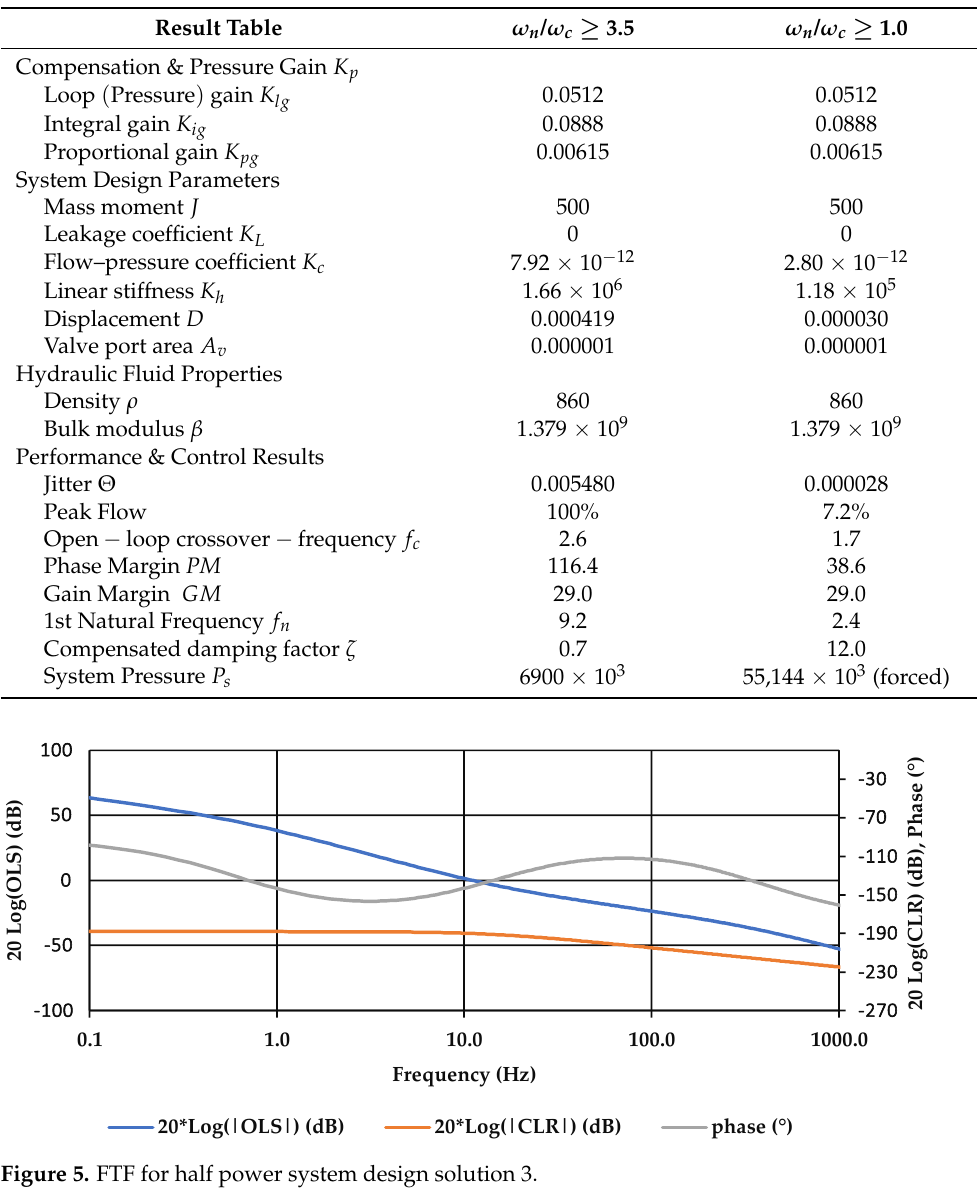
Figure 7. Frequency response for unbound system design solution 2. 4. Discussion We find reduced linear stiffness once we relaxed the frequency – ratio constraint. Re- duced stiffness is not feasible with typical axis damping. The frequency – ratio constraint value of 1.0 reflects a well-damped OLS FTF with the potential to set equal the crossover frequency and FNF. Once the designer finds a damping solution for the plant, the solution space may be expanded towards improved performance. The jitter performance estimate favors a smaller actuator, which operates at a higher pressure. The peak power for the constant pressure hydraulic system is not reduced with displacement when there is a re- quirement to increase the system pressure to achieve the same actuator-force capability. However, the stabilization problem we have selected places no constraint on force capa- bility. To the extent that solution 1 provides greater displacement than that required to drive the load at the required bandwidth, the system pressure does not have to scale with displacement, as shown in Table 3. Because the bandwidth of solution 2 is less than that of solution 1, the maximum acceleration and force can be reduced in solution 2. At 2.6 Hz, the frequency response amplitude ratio is 0 dB for solution 1, while solution 2 includes an additional −4 0 dB/dec slope at that frequency compared to solution 1 and attenuation greater than −4 .5 dB. An attenuation of −4 .5 dB is a 65% power reduction. The system